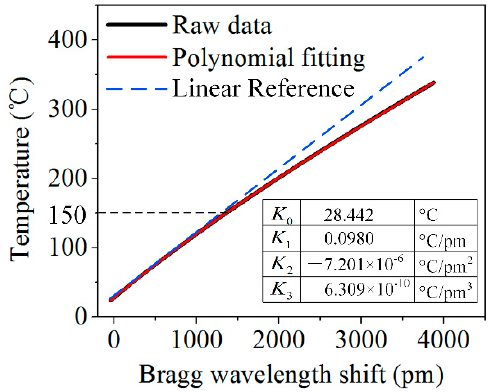
Figure 4. Temperature calibration using a cubic polynomial fitting equation.